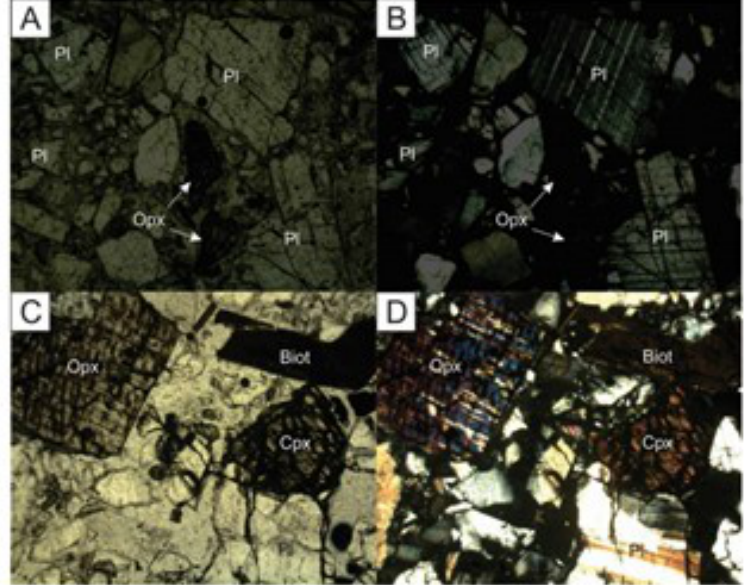
Figure 3. ( A ) PPL view showing Plagioclase feldspar (Pl) and Orthopyroxene (Opx); ( B ) XPL view showing Plagioclase feldspar (Pl) and Orthopyroxene (Opx); ( C ) PPL view showing Orthopyroxene (Opx), Biotite (Biot), Clinopyroxene (Cpx), and Plagioclase feldspar (Pl) ( D ) XPL view showing Orthopyroxene (Opx), Biotite (Biot), and